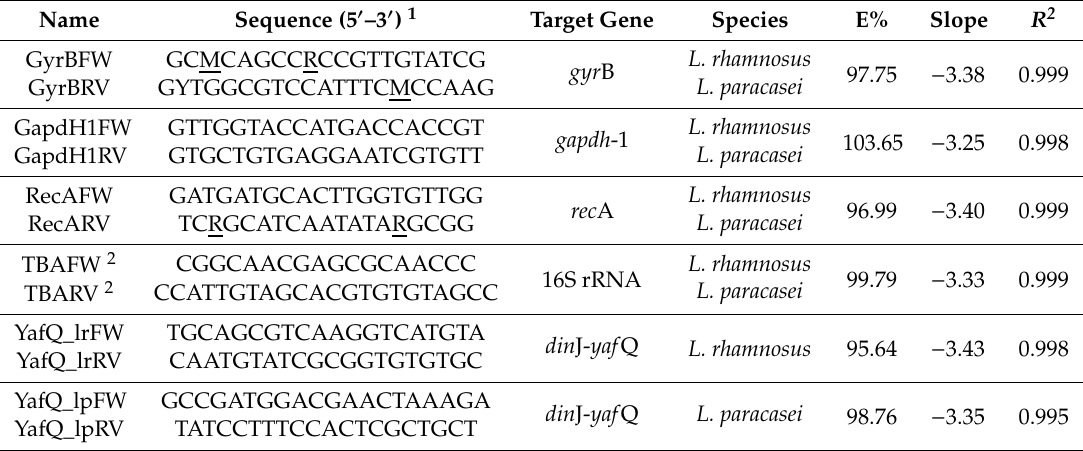
Table 4. Primer pairs used for RT qPCR